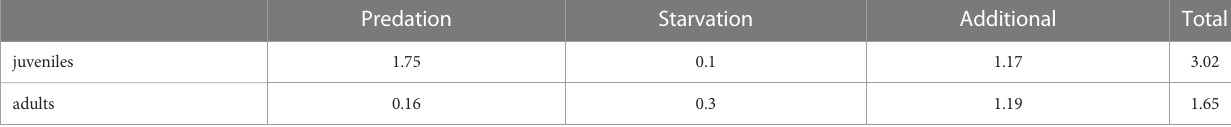
TABLE 1 Mortality rates (y – 1 ) of mesopelagic fi sh for different sources of mortality diagnosed by OSMOSE averaged after